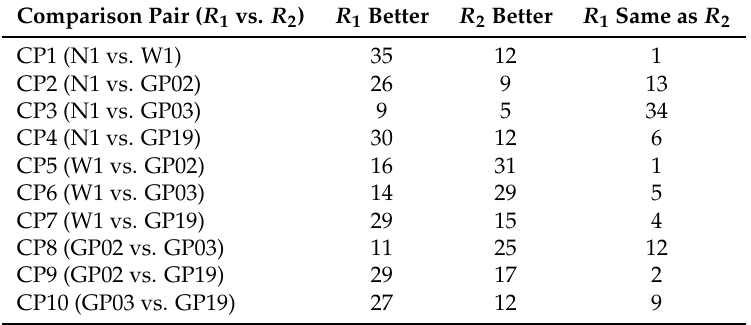
Table 5. Comparison results as number of selected faulty versions that one formula is better than another. Comparison Pair ( R 1 vs. R 2 )